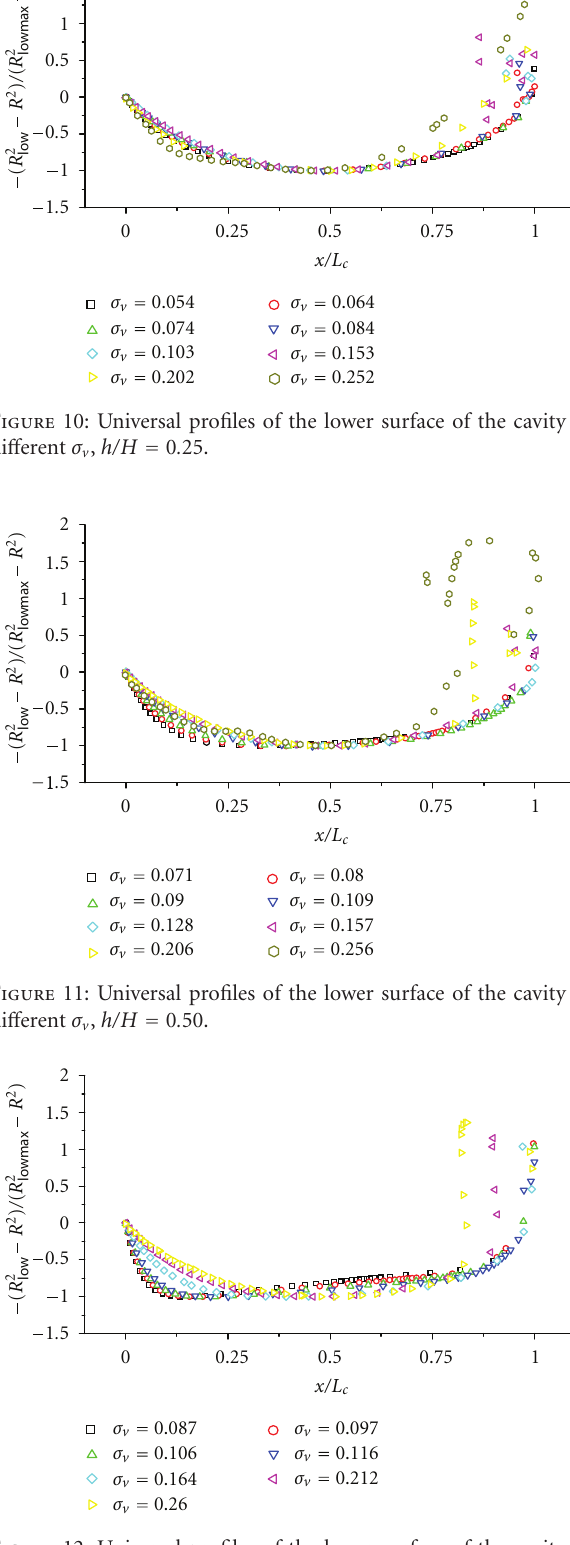
Figure 9: Universal profiles of the upper surface of the cavity at di ff erent σ v , h/H = 0 . 75.